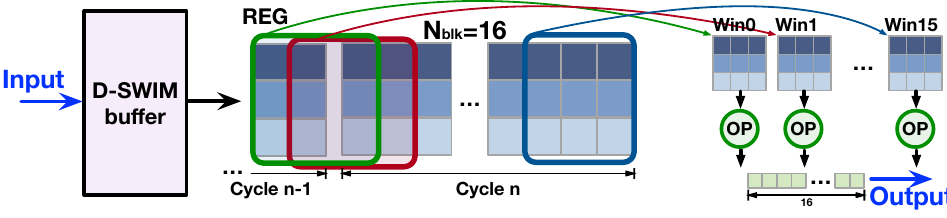
Figure 13. D-SWIM-based architecture for Conv2D (3 × 3